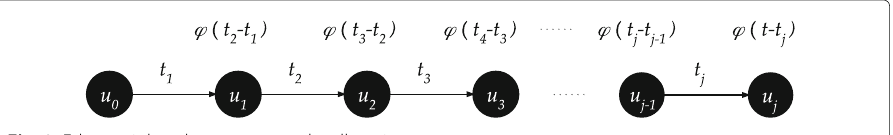
Fig. 2 Edge weights along a temporal walk at time